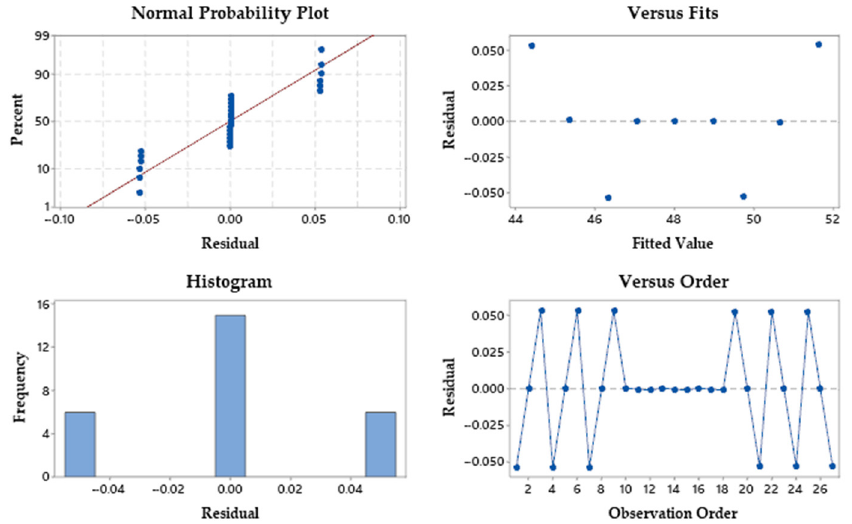
Figure 11. Residual plots for cutting efficiency.